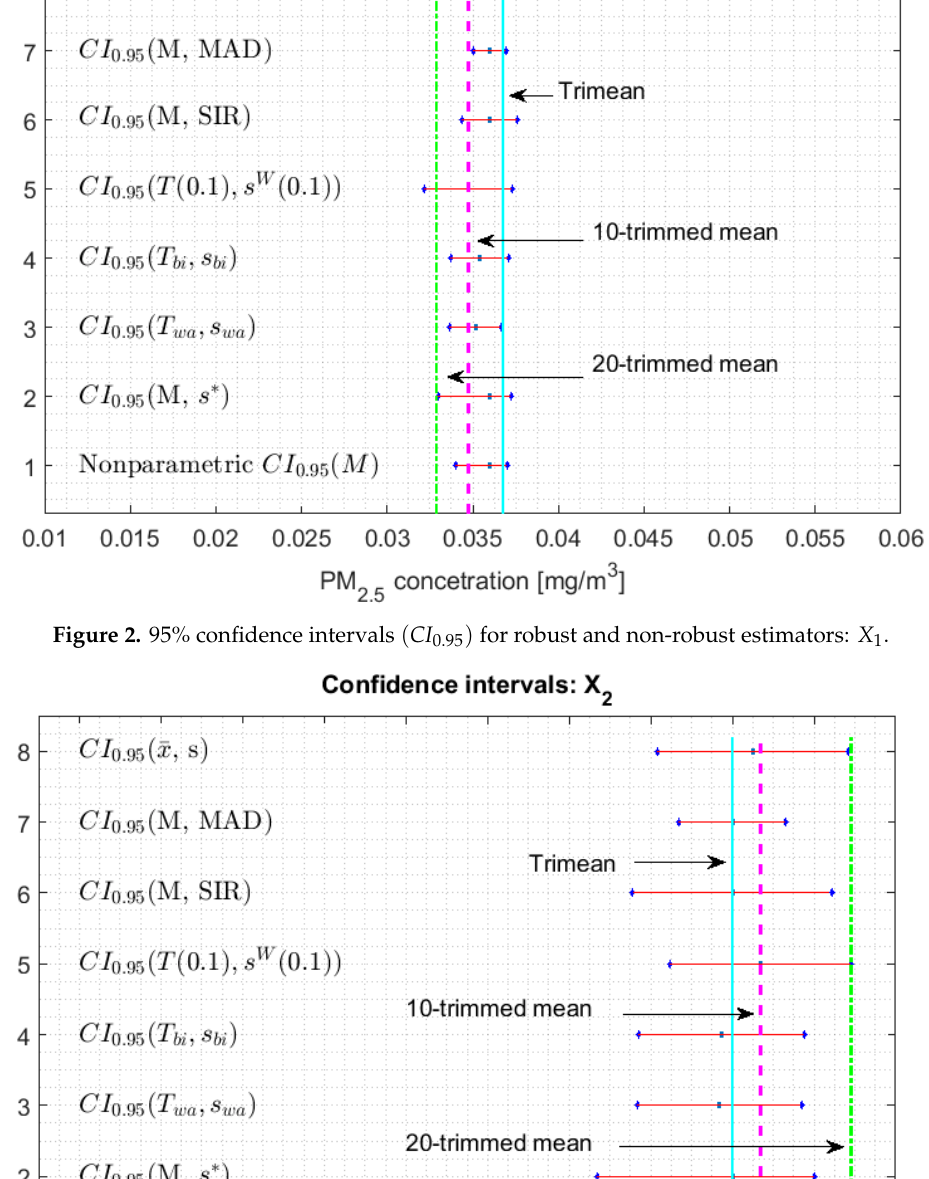
Figure 4. 95% confidence intervals (𝐶𝐼 (cid:2868).(cid:2877)(cid:2873) ) for robust and non-robust estimators: 𝑋 (cid:2871) .